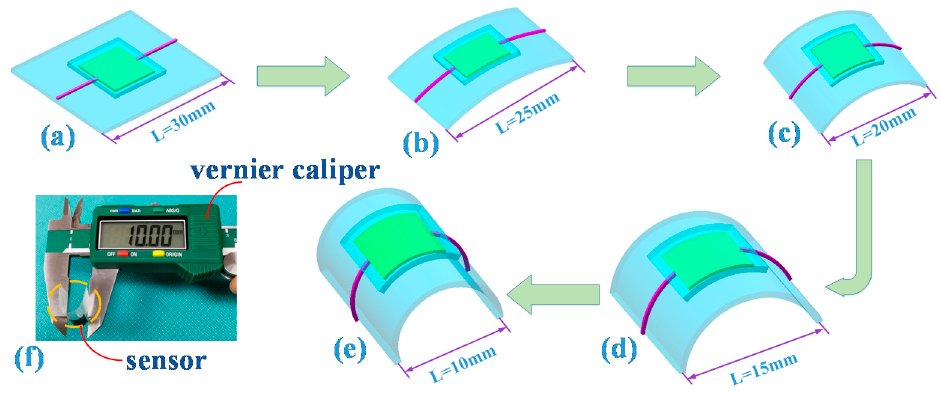
Figure 6. The length of the long side of the sensor (L) and bending schematic diagram of the temperature sensor: ( a ) L = 30 mm; ( b ) L = 25 mm; ( c ) L = 20 mm; ( d ) L = 15 mm; ( e ) L = 10 mm; ( f ) the way to control the bending.